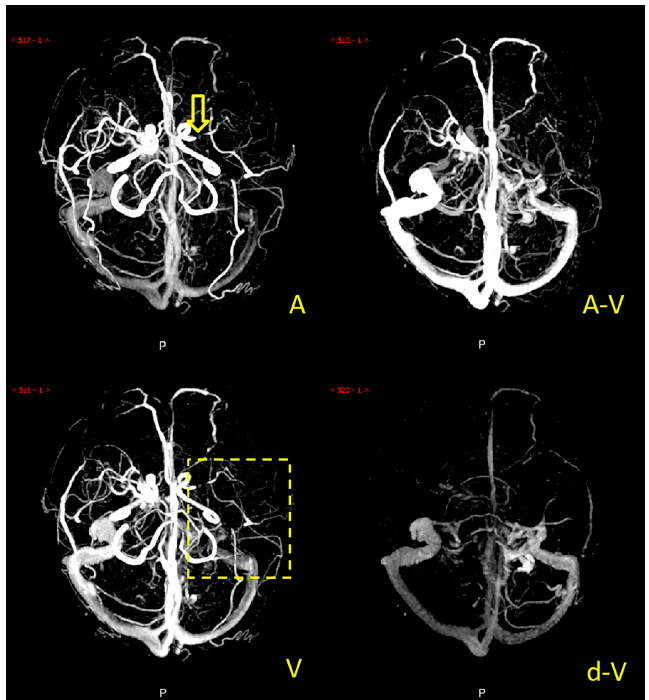
Figure 2. Example of a patient with poor collateral circulation. Note: The patient’s left middle cerebral artery was occluded (the yellow arrow), and there was no major collateral vessel in the left middle cerebral artery blood supply area (the yellow dashed box) of A (arterial phase), A-V (arteriovenous phase), V (venous phase), and d-V (venous late phase).